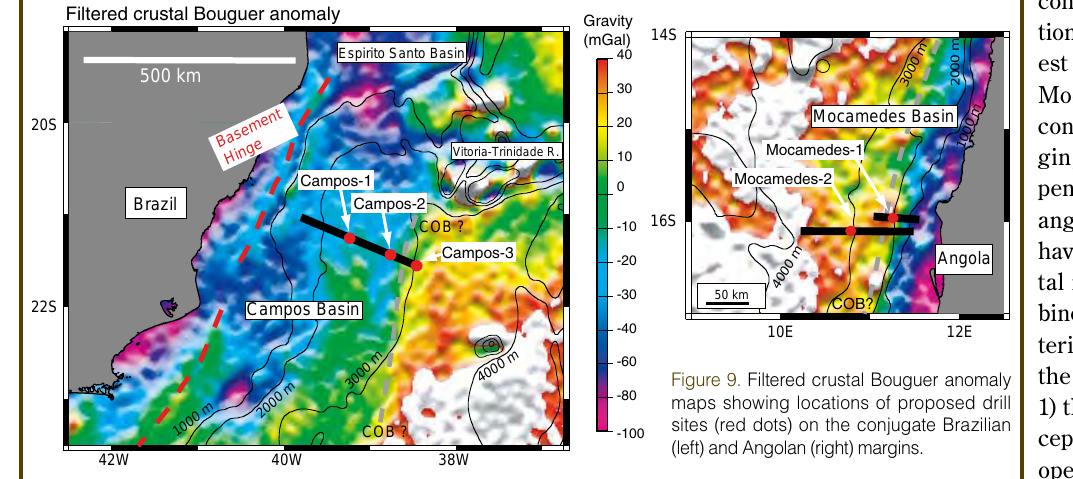
Figure 9. Filtered crustal Bouguer anomaly maps showing locations of proposed drill sites (red dots) on the conjugate Brazilian (left) and Angolan (right)